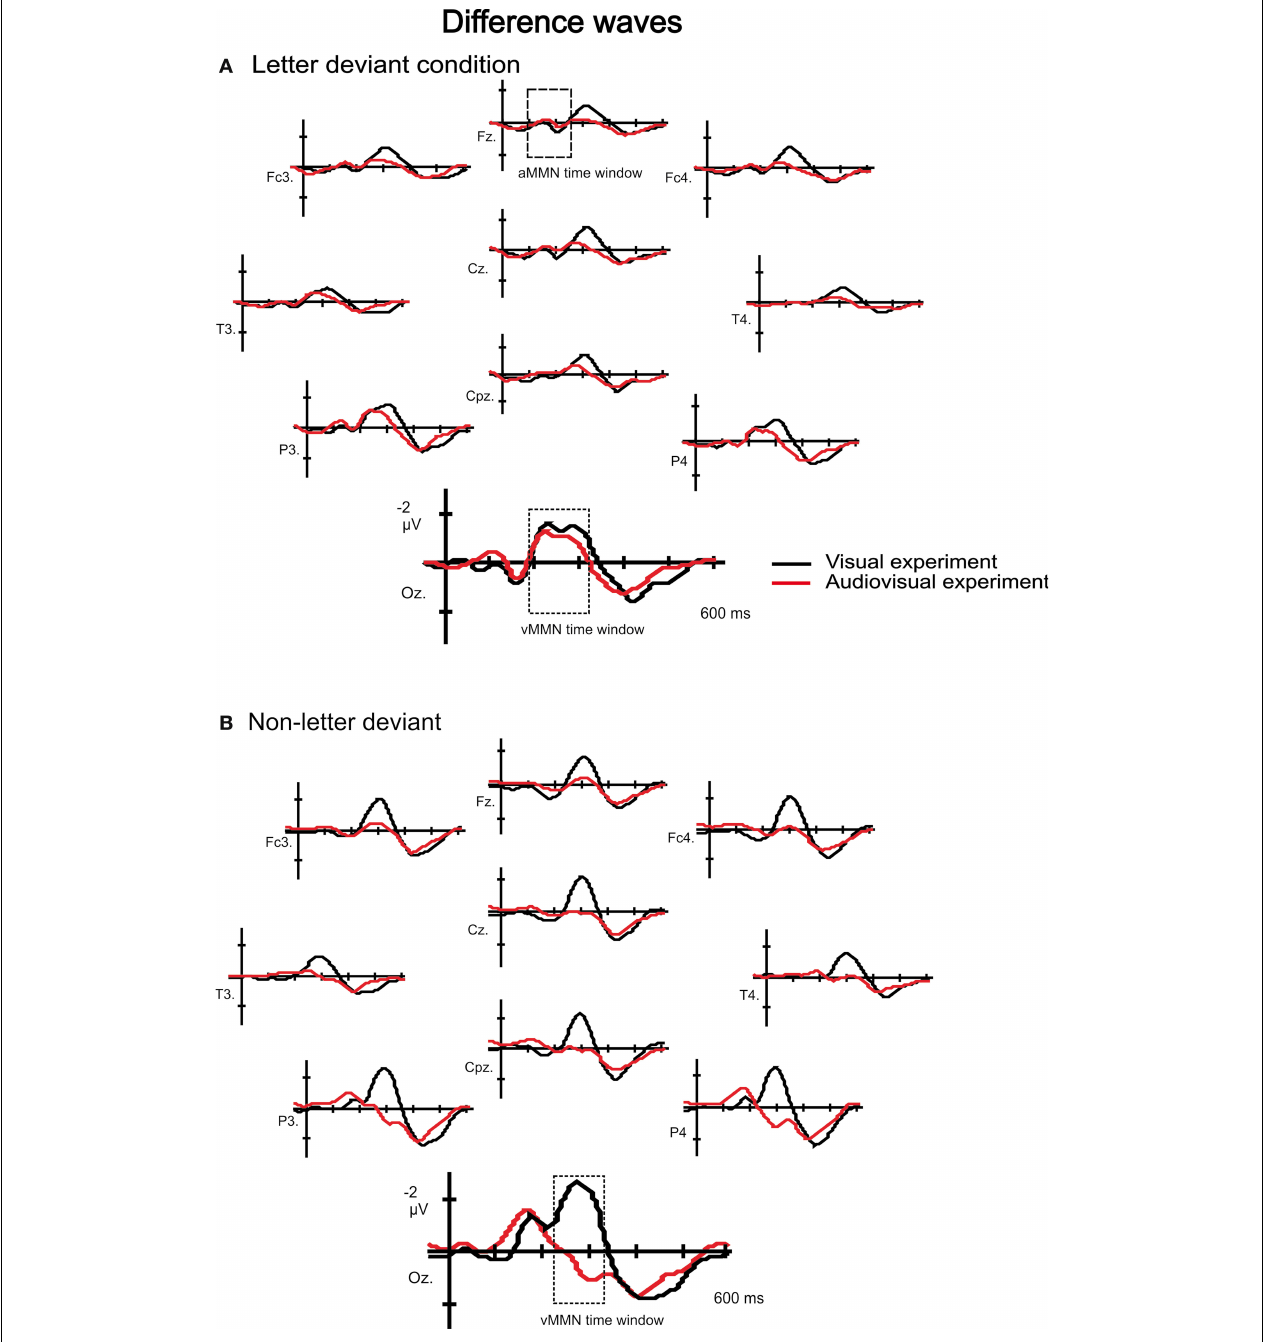
FIGURE 3 | Difference waves to letter (A) and non-letter deviants (B) observed at 10 electrodes (Fz, Fc3, Fc4, Cz, T3, T4, Cpz, P3, P4 and Oz) in the visual experiment (black lines) and the audiovisual experiment (red lines). Besides the two time windows of interest, the assumed auditory MMN time window is indicated in electrode Fz in the letter condition (A)